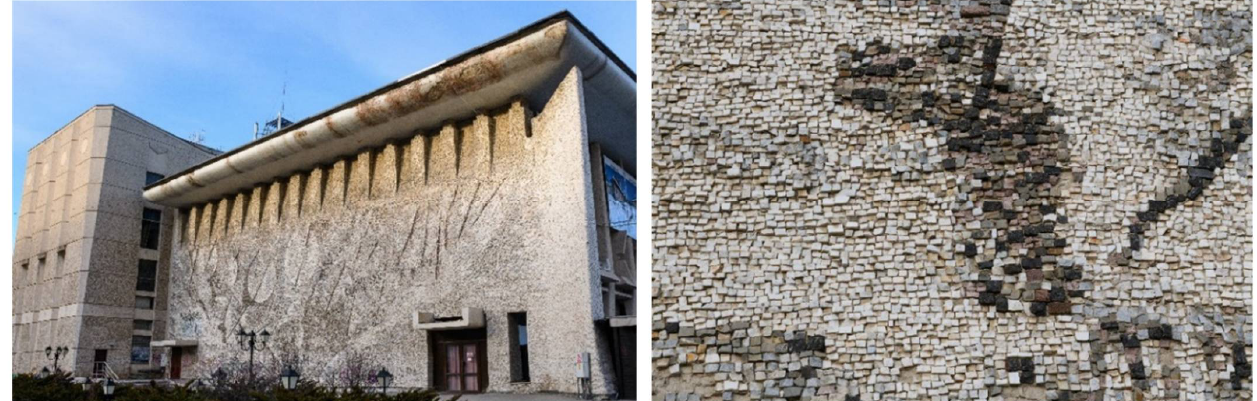
Figure 6. “The Song of the Upper Land” mosaic on the facade of the House of Culture. (Source: Petru Palamar).